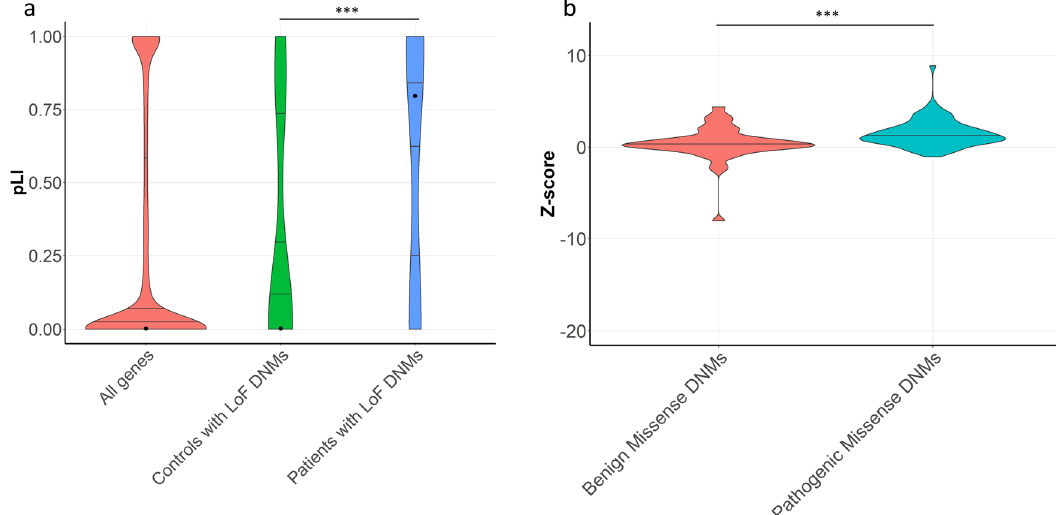
Fig. 1 Analysis of the intolerance to loss-of-function and missense variation in genes with de novo mutations. a Violin plot with quantile lines showing pLI scores in all genes in gnomAD (red), all genes affected by rare protein-altering loss-of-function (LoF) de novo mutations (DNMs) in a control population (http://de novo-db.gs.washington.edu/de novo-db/) (green) and in all genes with a rare protein-altering LoF DNM in our trio cohort (blue). Using the permutation-based, nonparametric test de fi ned by Lelieveld et al. 64 a signi fi cant enrichment of LoF DNMs in LoF-intolerant genes in patient cohort was detected in comparison to the number of LoF in fertile control cohort (DNM LoF mutations in patients n = 17, median pLI in patients with male infertility = 0.80, DNM LoF mutations in controls n = 21, median pLI in controls = 3.75 × 10 − 5 , p value = 1.00 × 10 − 5 , N simulations = 100,000). The black dot indicates median pLI scores. b Violin plot with quantile lines showing the distribution of Z-scores for genes with predicted benign ( n = 59) and pathogenic missense DNMs ( n = 63) in infertile patients. A signi fi cant increase in predicated pathogenic DNMs in missense-intolerant genes was detected compared to benign missense DNM (Two-sided Mann – Whitney U test, p value of 3.44 × 10 − 4 ). (*** p value <